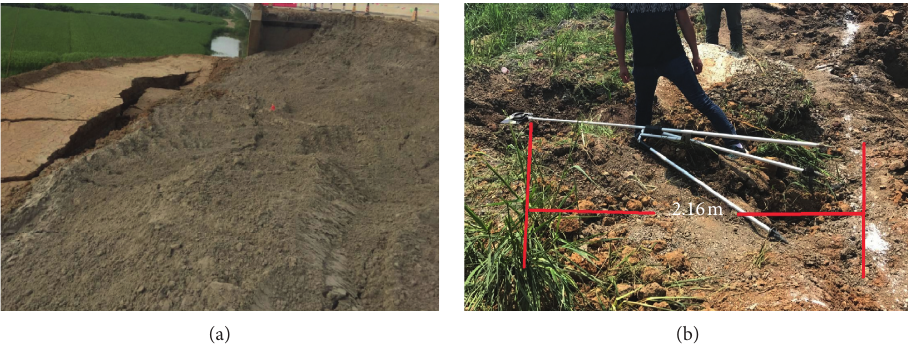
Figure 4: Subgrade collapse site. (a) Collapse area and (b) axis offset of the pile top.